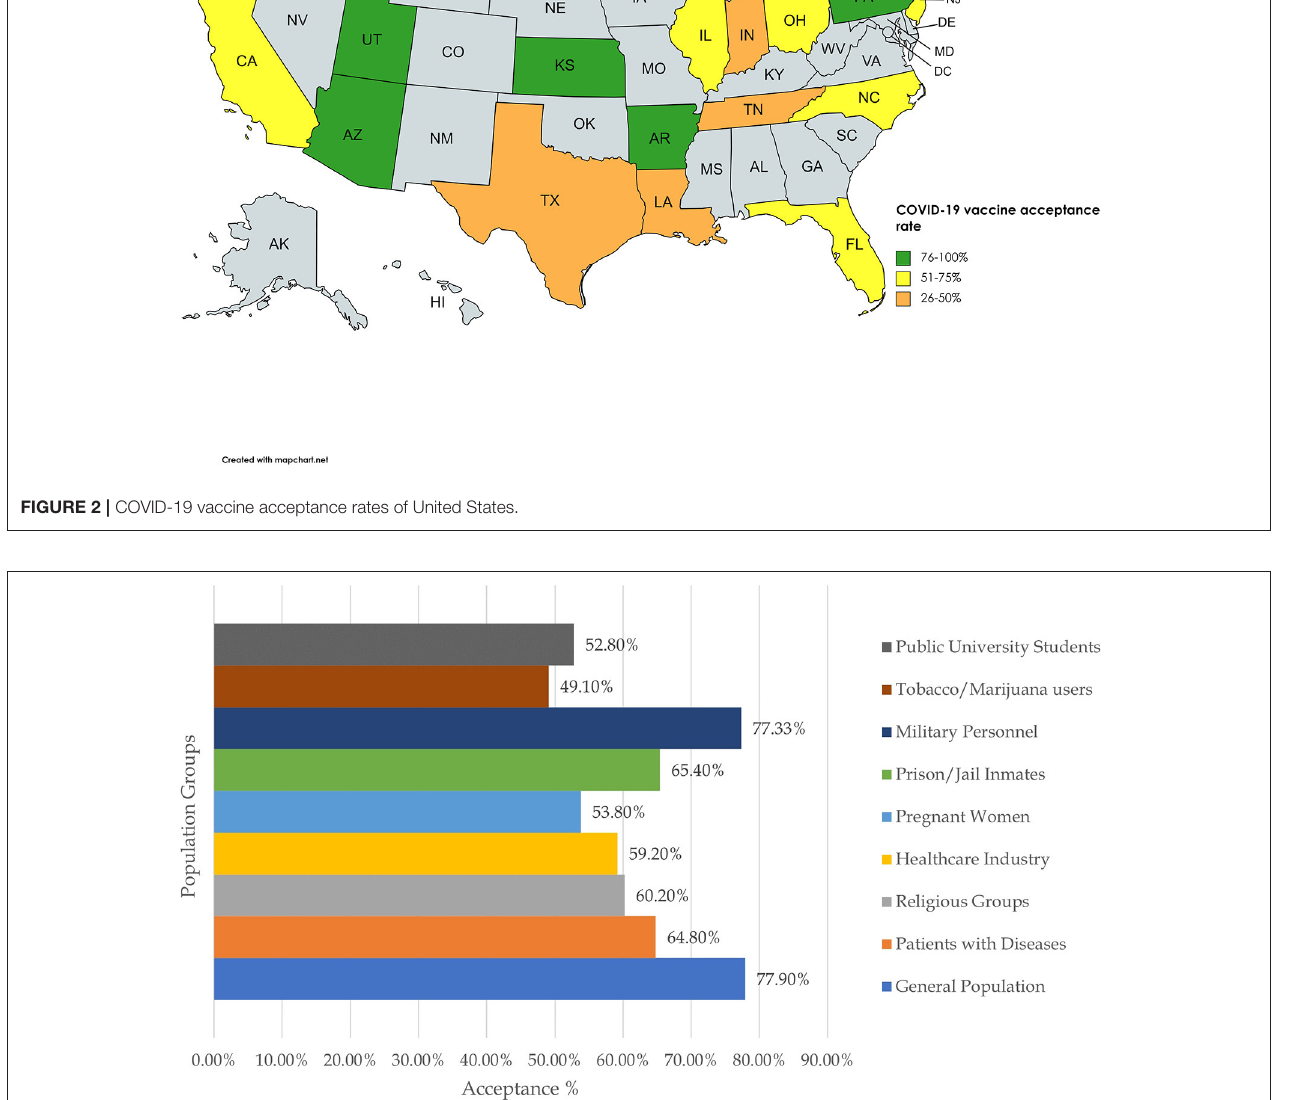
FIGURE 3 | COVID-19 vaccine acceptance stratified per-respondents’